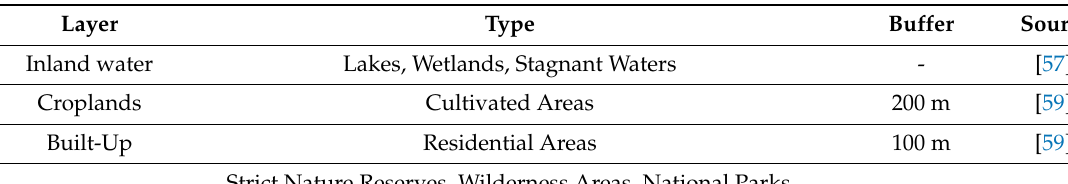
Table 3. List of the type and source of restrictions zones used for the technical assessment of small-scale hydropower in Sub-Saharan